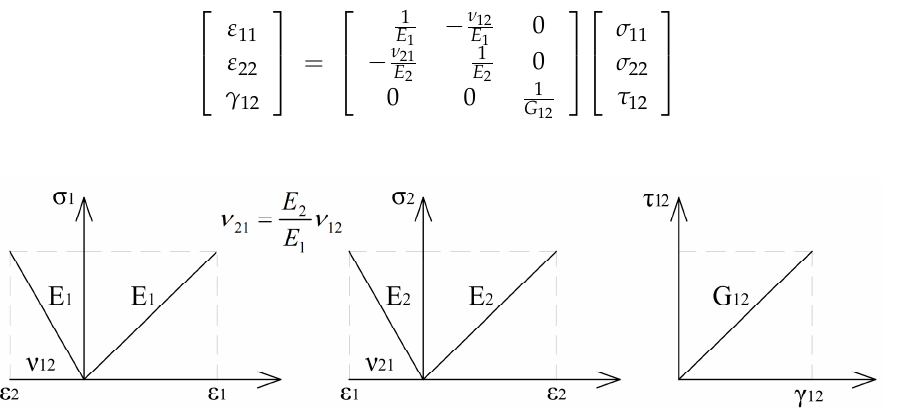
Figure 6. Constitutive law for an elastic orthotropic material model representing timber.